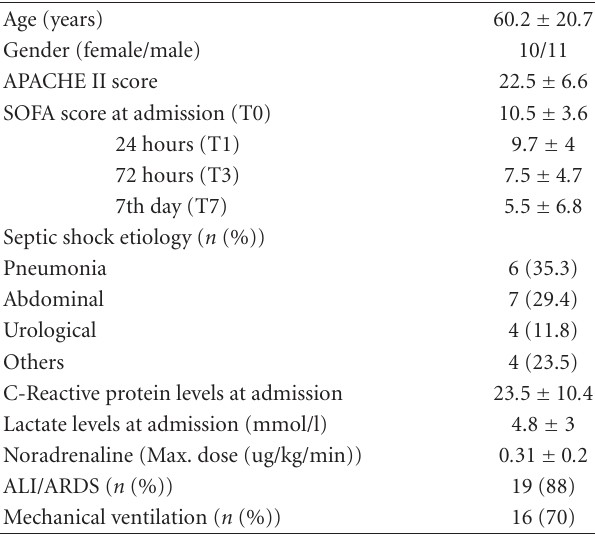
Table 1: Characteristics of the patients.